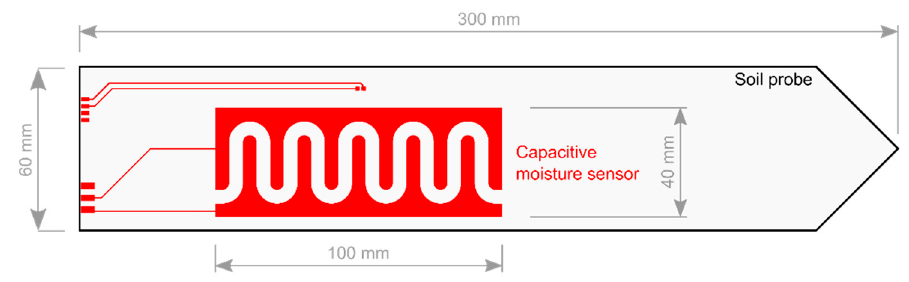
Figure 2. Design of soil probe with printed capacitive moisture sensor.